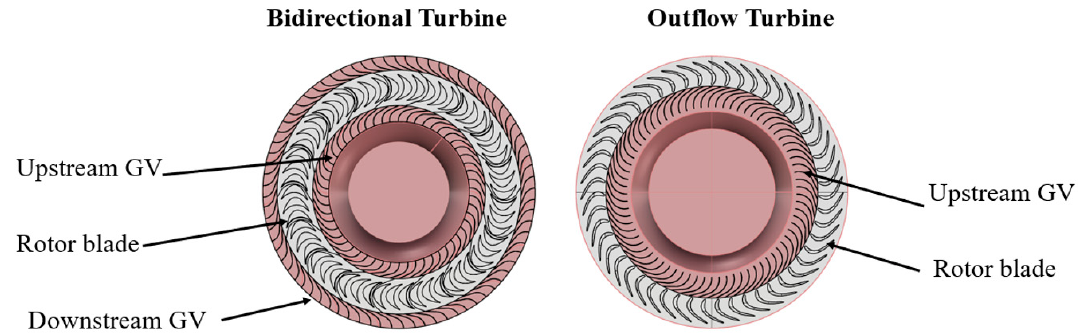
Figure 1. Schematics of the bidirectional turbine and initial outflow turbine geometries.